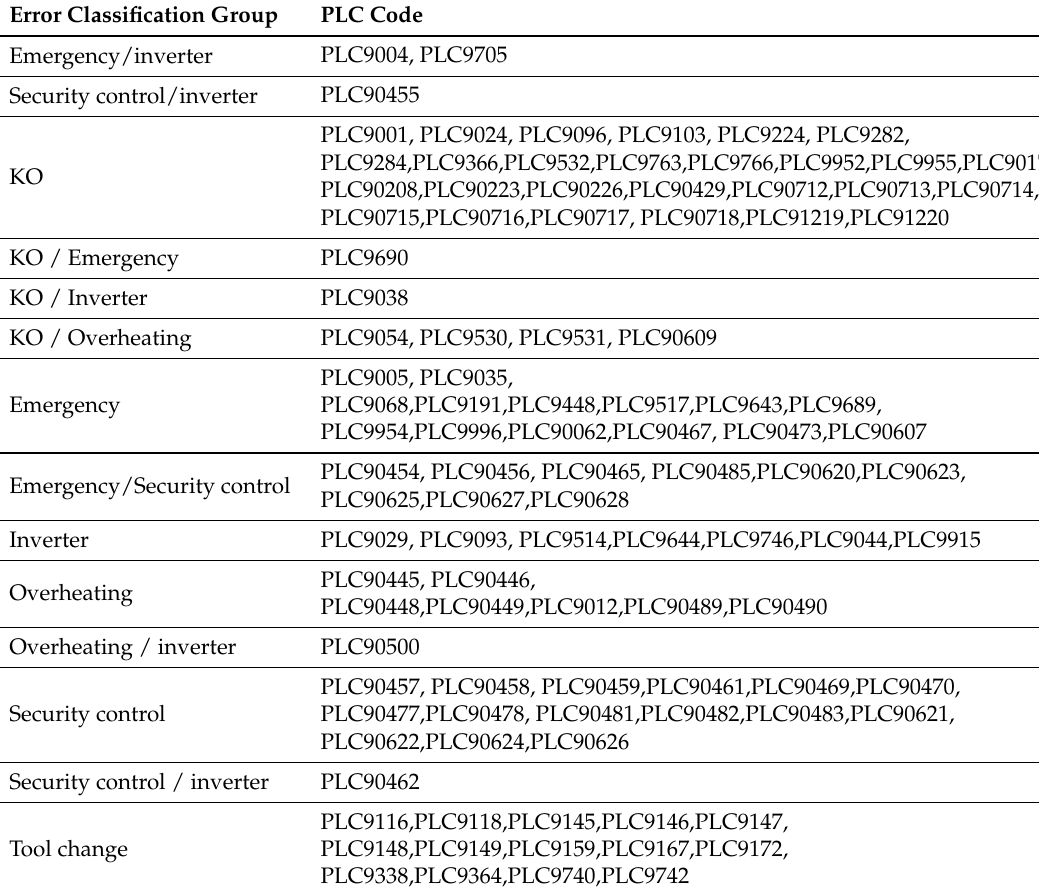
Table A2. Error Classification of PLC error code. KO: unexpected stop error.